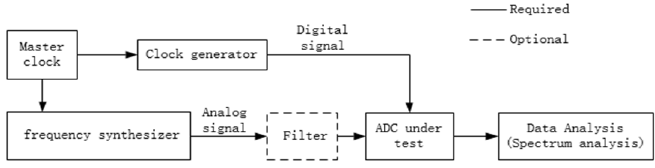
Figure 1. Spectral test setup.